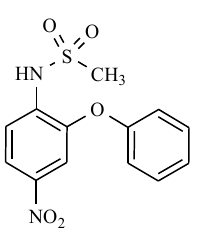
Figure 22. Nimesulide.